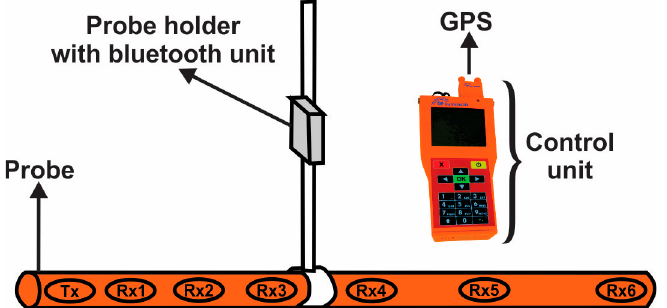
Figure 2. CMD MiniExplorer 6L meter including probe with one T x coil and six R x coils, probe holder with a Bluetooth unit and control unit with